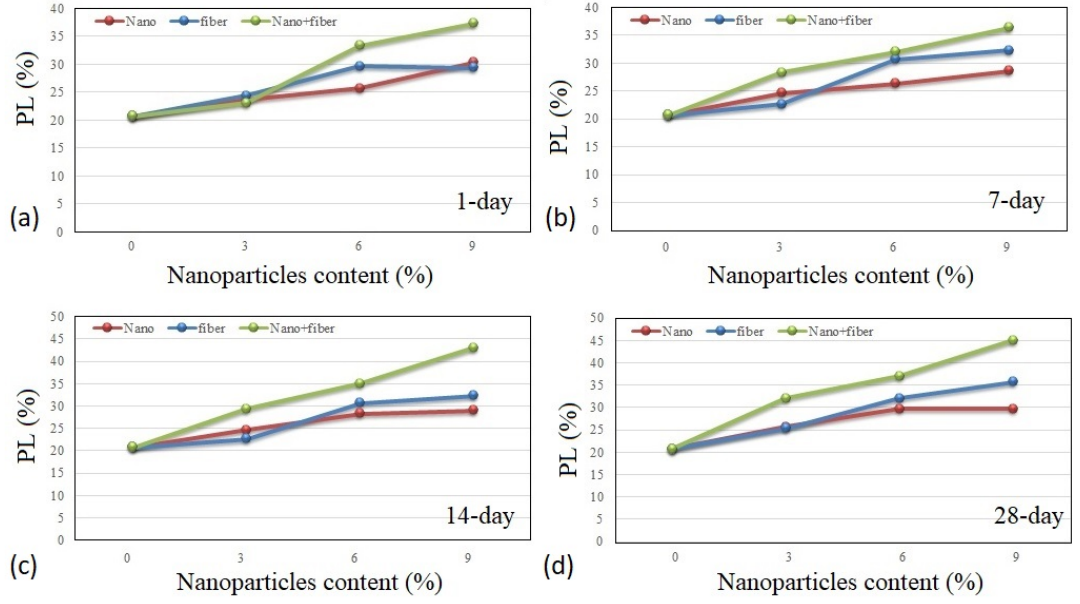
Figure 7. Plastic limits results were measured for different groups of the samples: ( a ) 1-day, ( b ) 7-day, ( c ) 14-day, ( d ) 28-day.